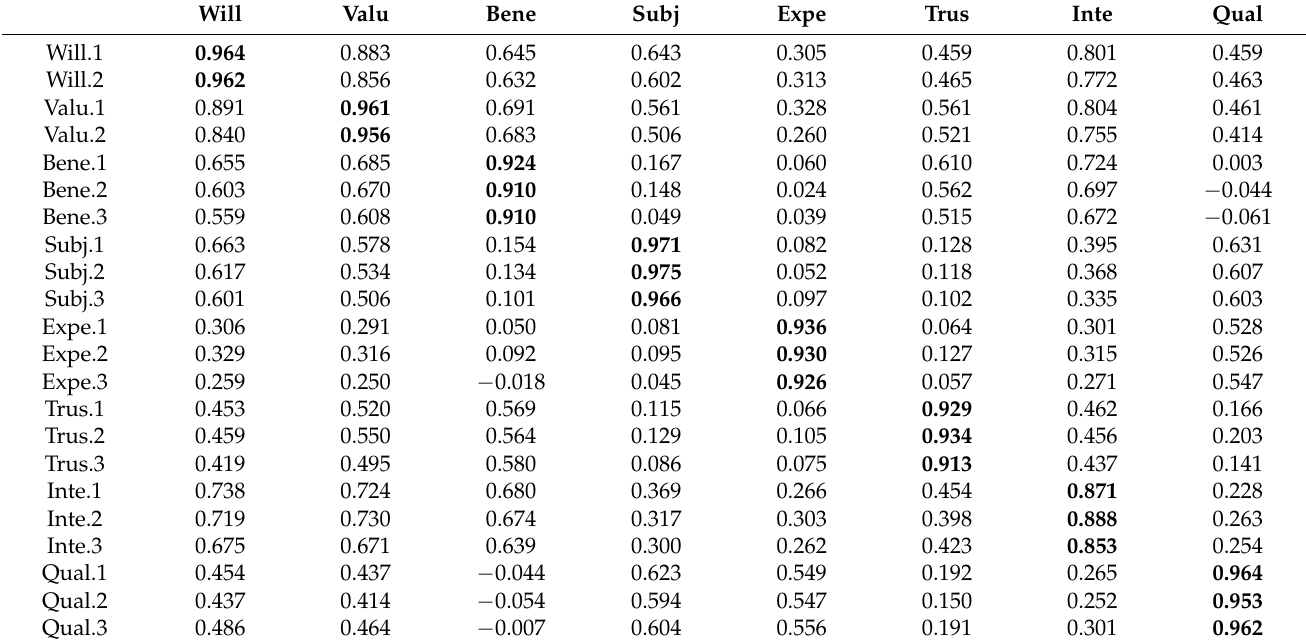
Table 3. Factor loadings and cross